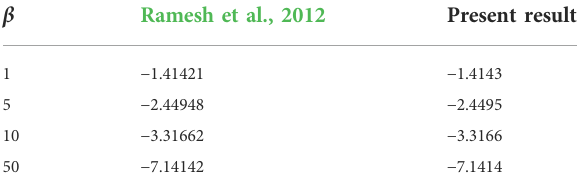
TABLE 1 Comparison of present numerical results with previous ones. β Ramesh et al., 2012 Present result